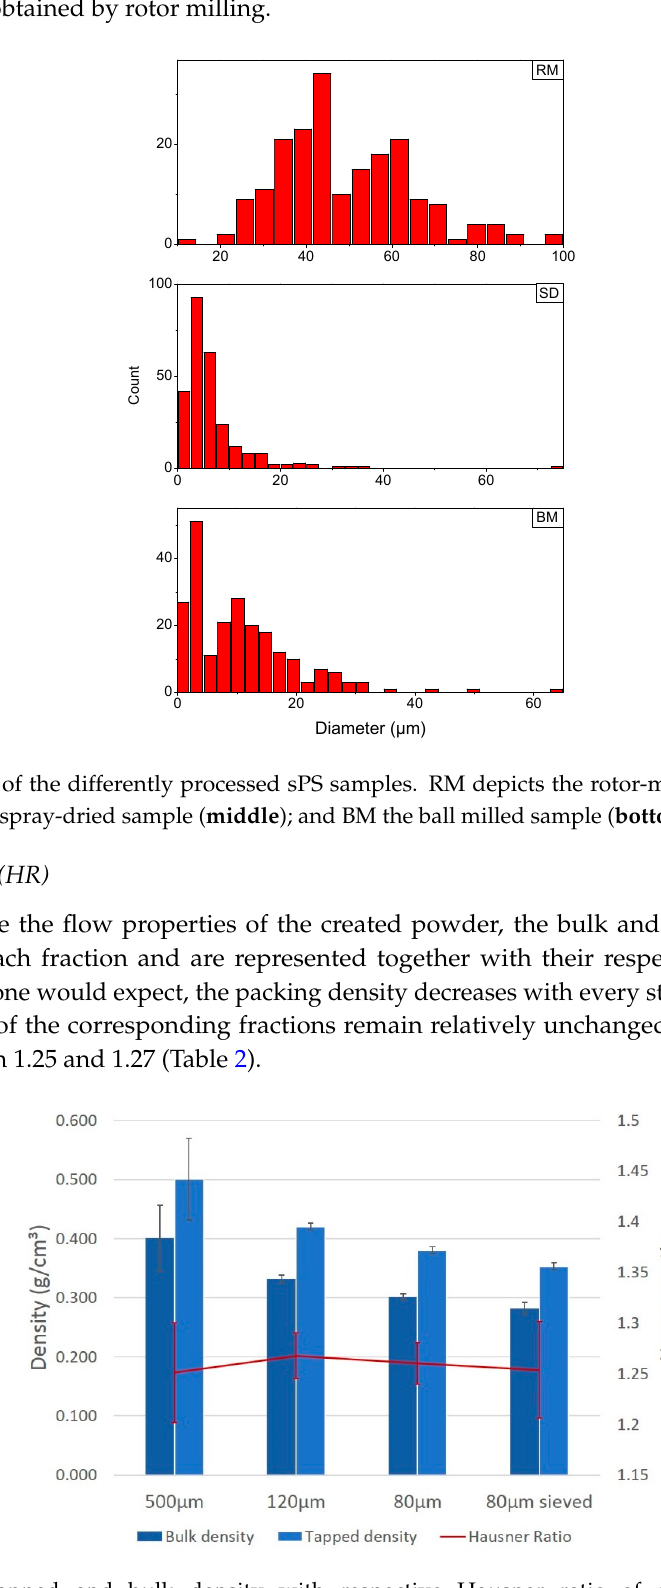
Figure 5. Tapped and bulk density with respective Hausner ratio of each stage in the rotor-milling process.